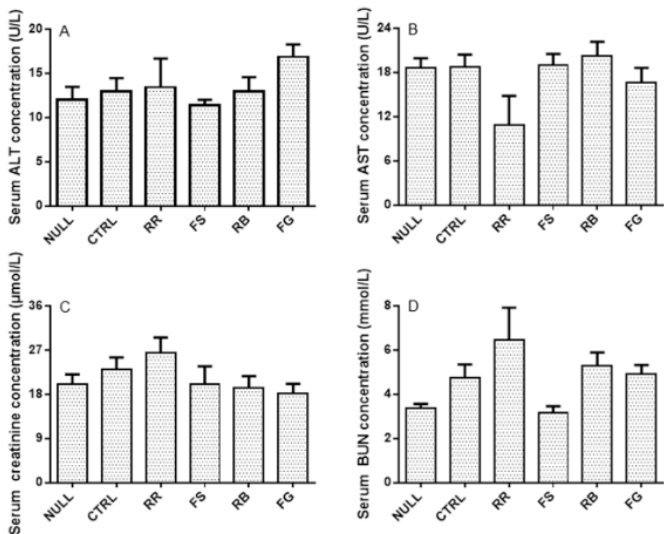
Figure 3. Serum concentrations of alanine aminotransferase (ALT; A ), aspartate aminotransferase (AST; B ), creatinine (CR; C ), and blood urea nitrogen (BUN; D ) after 11-day treatment of vehicle (CTRL) and clozapine (CLZ) with or without Radix Rehmanniae (RR), Fructus Schisandrae (FS), Radix Bupleuri (RB), and Fructus Gardeniae (FG), respectively. The data are presented as mean ± SEM.